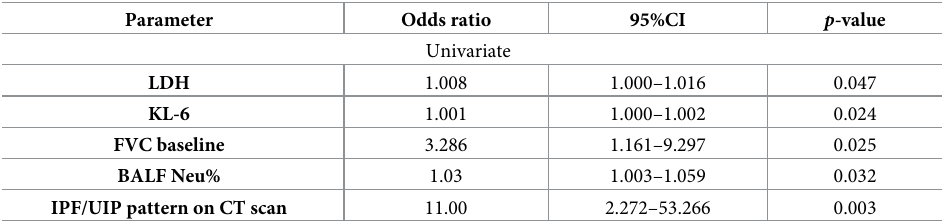
Table 4. Predictive markers of death in the PF-ILD group within 3 Years, based on univariate logistic regression